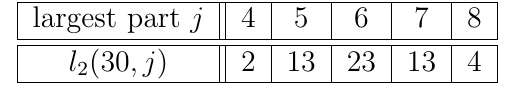
Table 9: Number l (30 , j ) of forcibly biconnected graphical partitions of 30 with given largest 2 term j